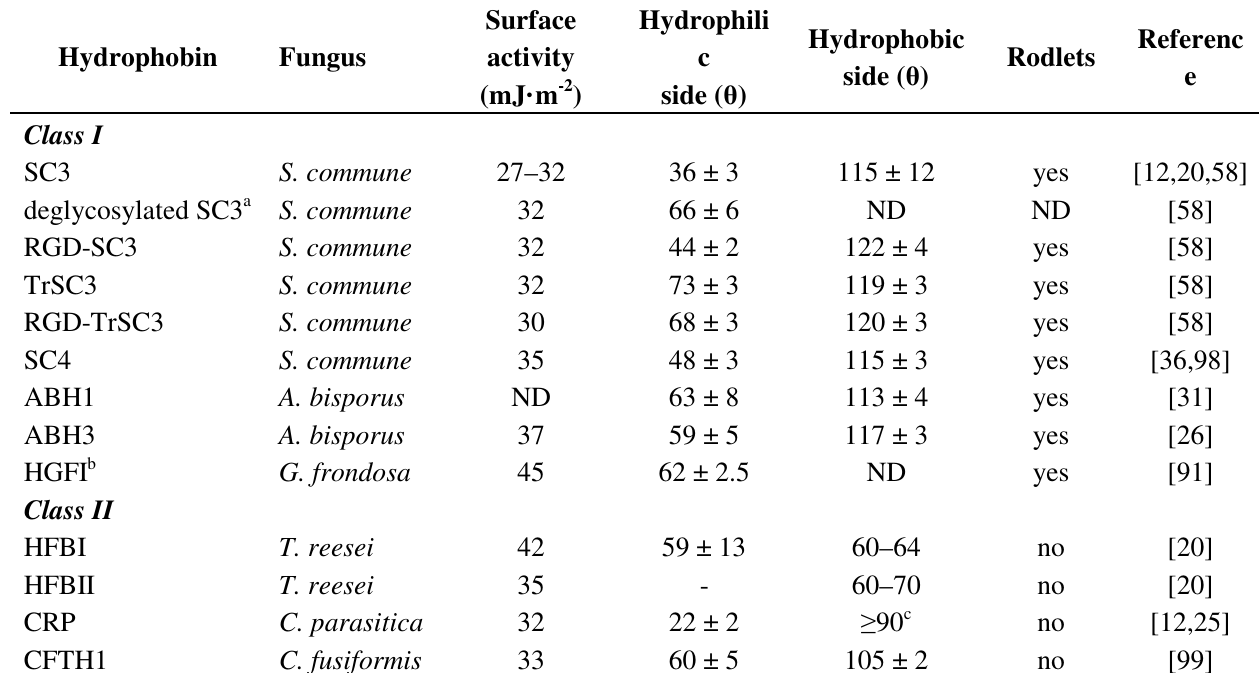
Table 1. Physiochemical properties of natural and engineered class I and class II hydrophobins. Surface activity measurements and coatings were performed at 100 µg·mL −1 unless mentioned otherwise. ND, not determined; a 22 µg·mL −1 ; b 80 µg·mL −1 ; c coating not homogenous.